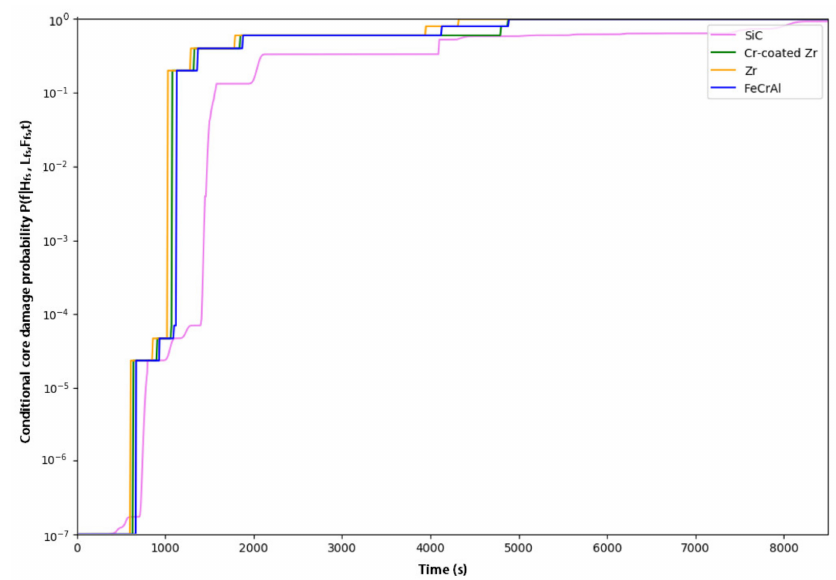
Figure 8. Conditional core damage probability for different fuel